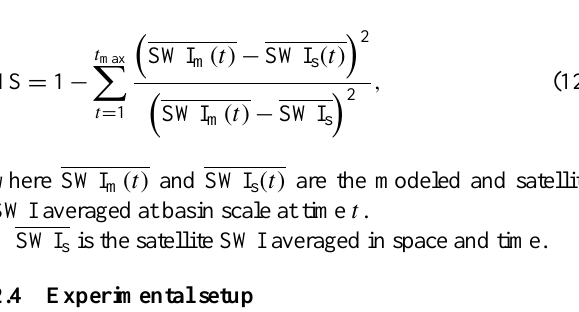
Table 2. Range of variability of the parameters used in the calibra- tion and uncertainty